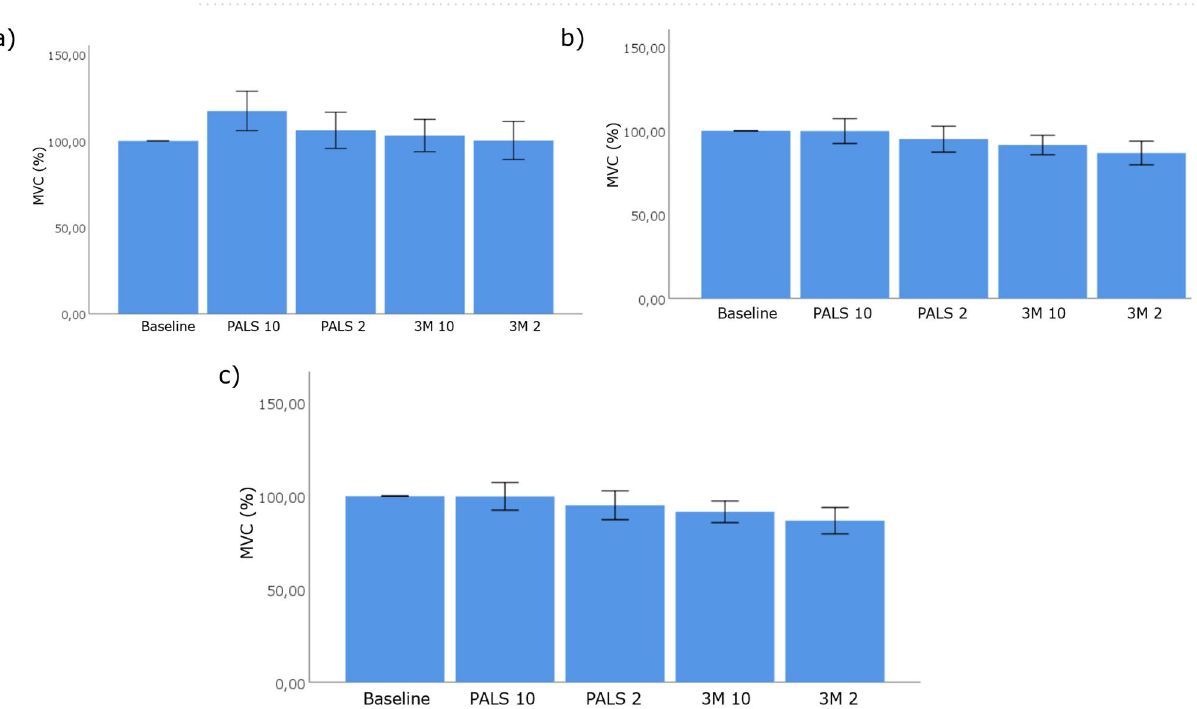
Figure 4. Mean peak forces of the index ( a ) and middle finger ( b ) for the 5 different conditions. The mean value of the index and middle finger forces results in virtual finger forces ( c ). Data represented as mean ± SEM, normalized by baseline MVC. No significant differences in peak finger forces have been found with one-way ANOVA with Bonferroni adjustment. MVC, Maximum Voluntary